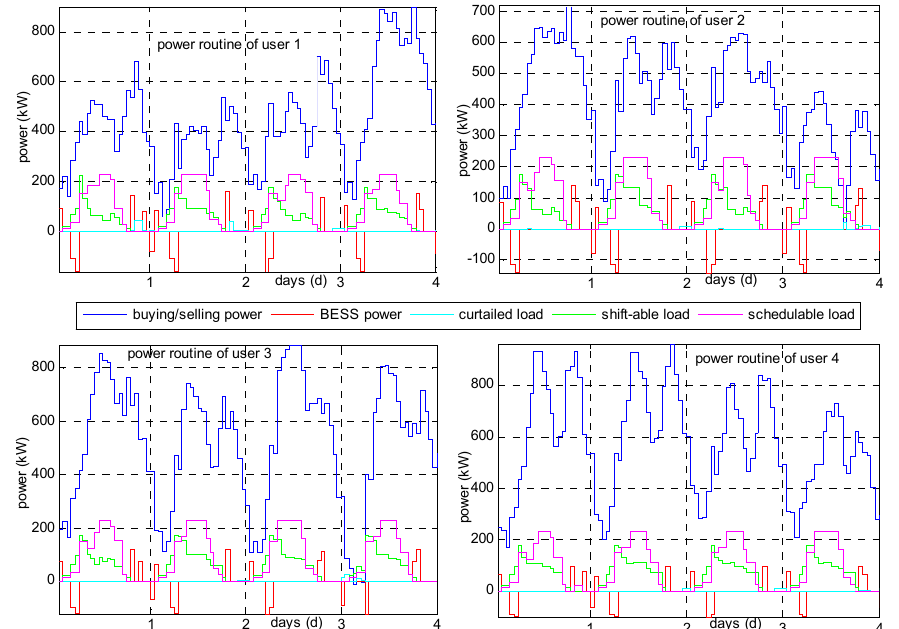
Figure 5. Power routine for each user and each dispatchable units with DMPC strategy.